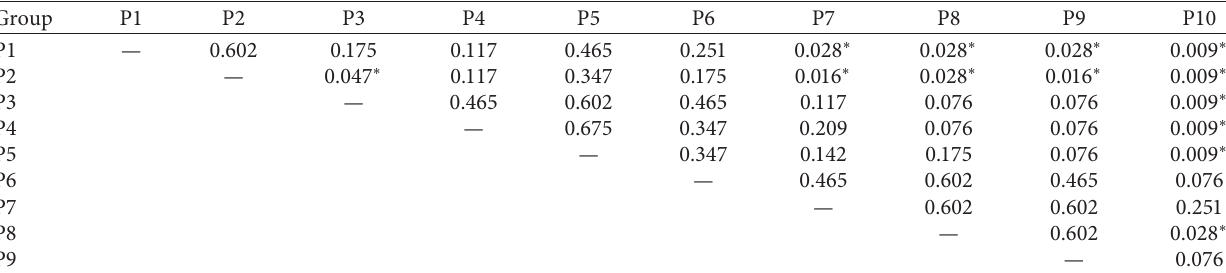
Table 4: The result of the Mann–Whitney test for testing differences.